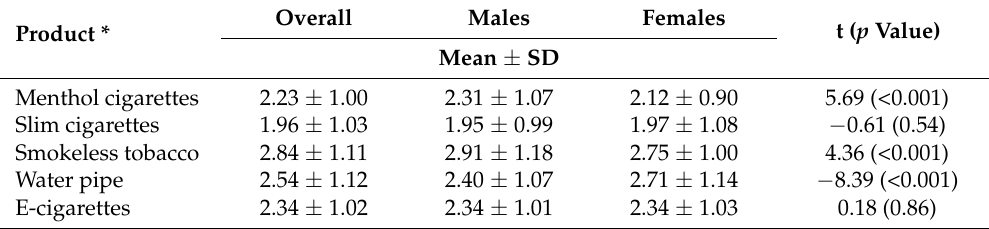
Table 1. Mean scores for the perceived harmfulness of the selected tobacco/nicotine products by gender.